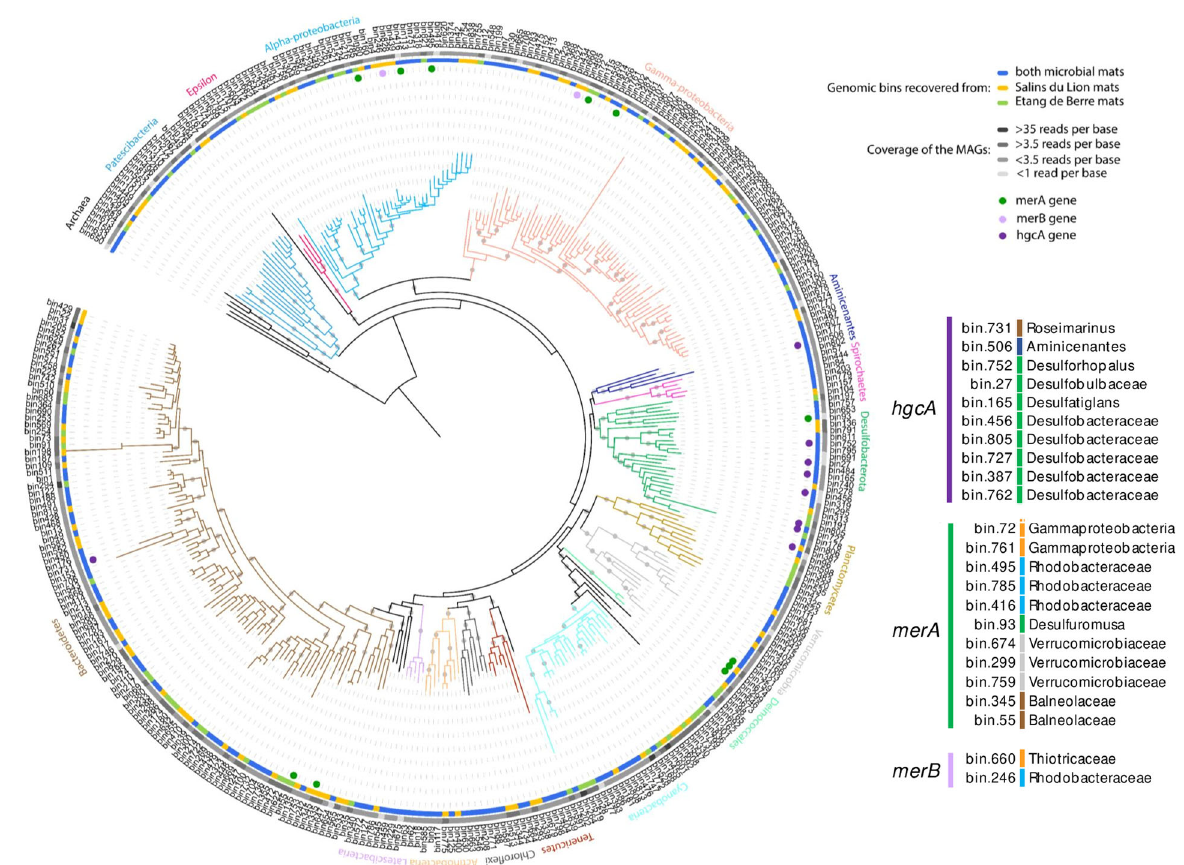
Fig. 3 Phylogenomic tree of the 407 high- to medium-quality genomic bins recovered from the microbial mat metagenomes. The tree was constructed on the concatenated alignment of ribosomal protein genes. Only genomic bins with more than 50% of the ribosomal protein genes were included in the analysis. The tree was rooted with the archaeal bins. Branches are color coded as in Fig. 1. Purple, green, and pink dots indicate the detection of hgcA , merA , and merB genes in the bins, respectively. Colored circle at the edge of the branches indicates the microbial mat of origin of the bins with, in yellow and green, bins recovered only from SL and EDB samples, respectively, and in blue, bins recovered from both microbial mat samples. The second circle in shades of gray indicates the average coverage of the MAGs. Only bootstraps >0.8 were represented by gray